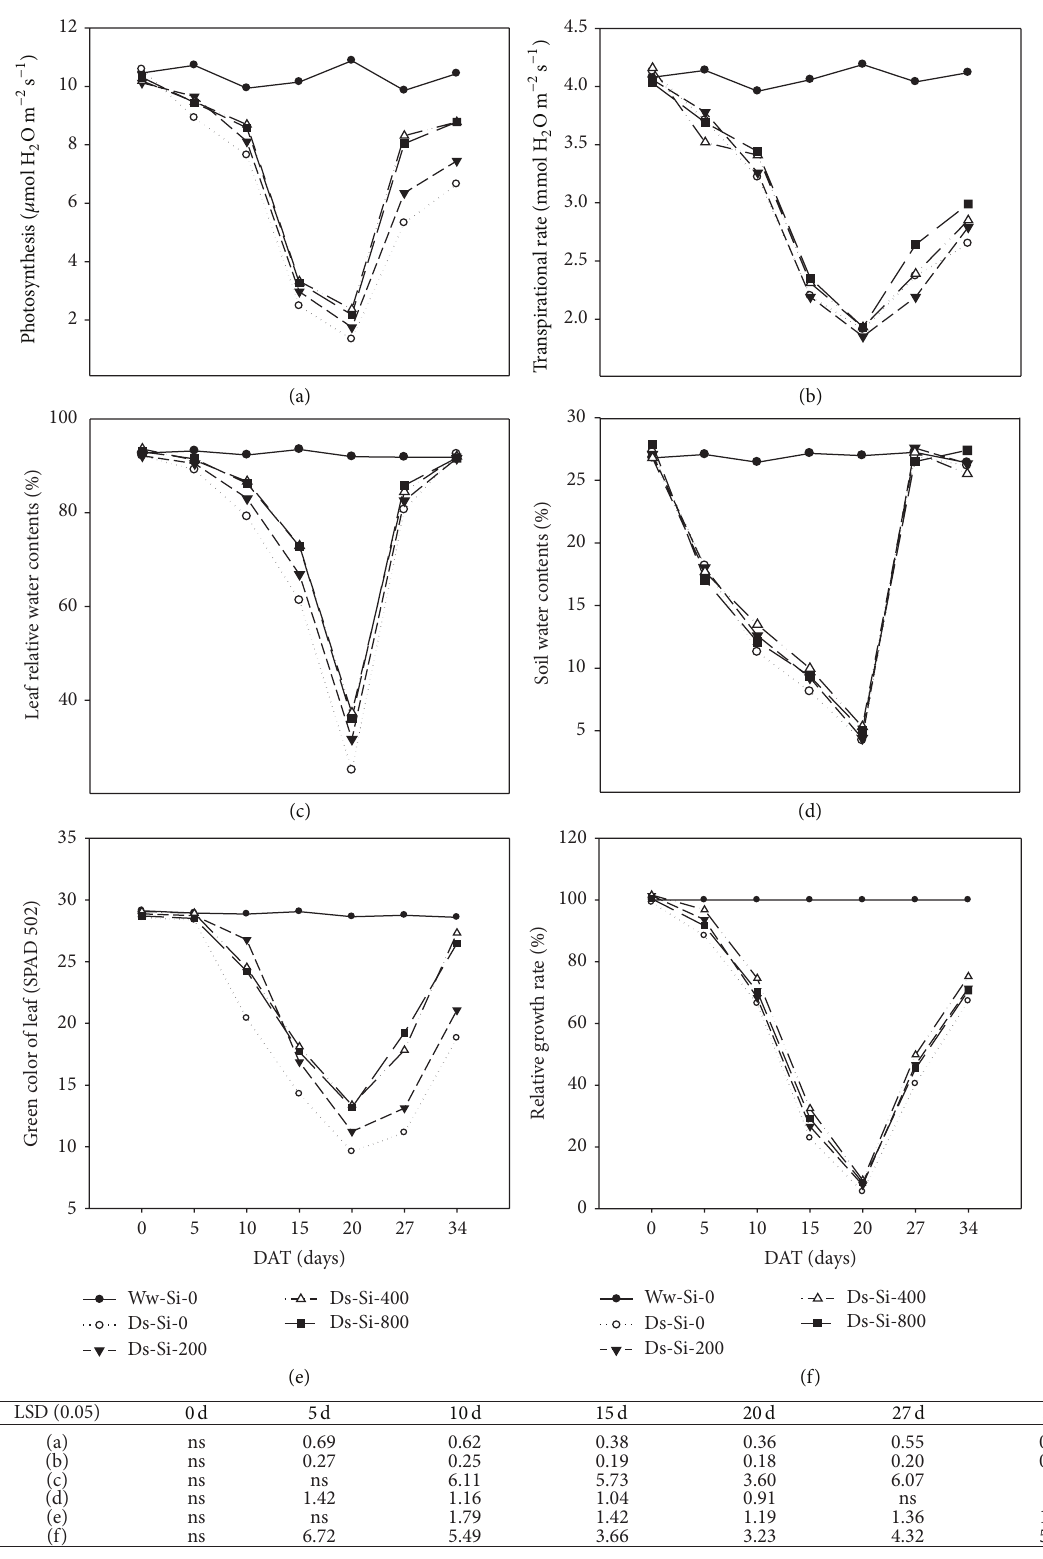
Figure 1: Influence of silicon application on (a) photosynthesis, (b) transpiration rate, (c) leaf relative water content, (d) soil water content, (e) green color of leaf, and (f) relative growth rate of Kentucky bluegrass under drought stress. ns: nonsignificant; DAT: days after treatment; Ww: well watered; Ds: drought stress; Si-0, Si-200, Si-400, and Si-800 means Si application at 0, 200, 400, and 800 mg L −1 , respectively. 0–20 DAT: drought stress period; 20–34 DAT: recovery